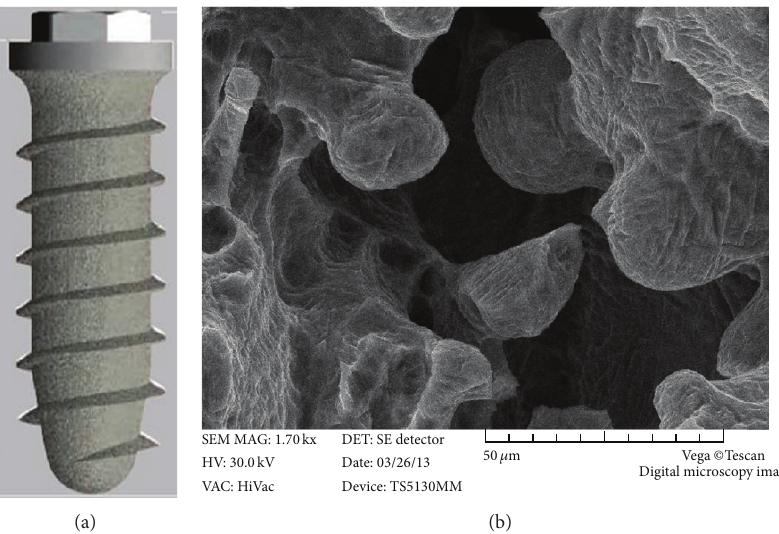
Figure 1: Macroscopical and microscopical features of the direct metal laser sintering (DMLS) titanium implants used in this study: the implants had an external hexagon connection (a); the scanning electron microscopy of the implant ( × 1700) showed a porous surface with ridge-like and globular protrusions, interspersed by intercommunicating pores and irregular crevices